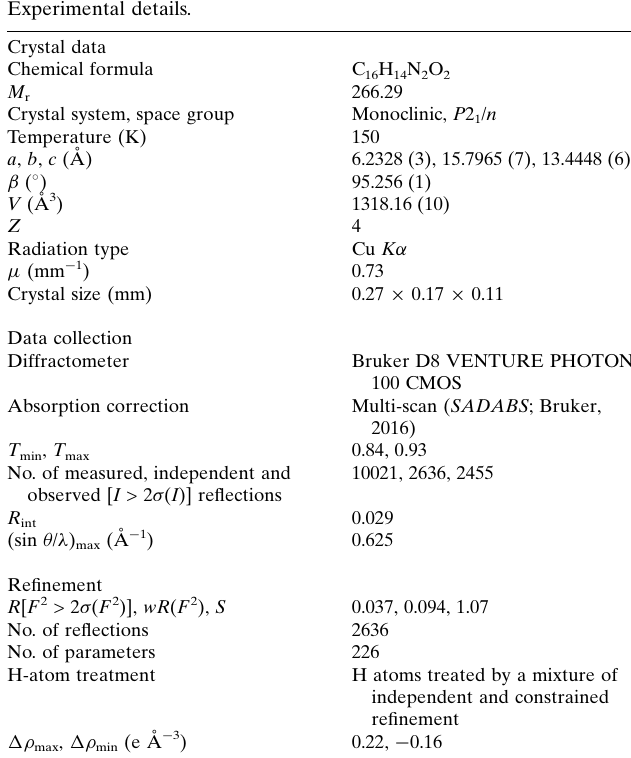
Table 2 Experimental